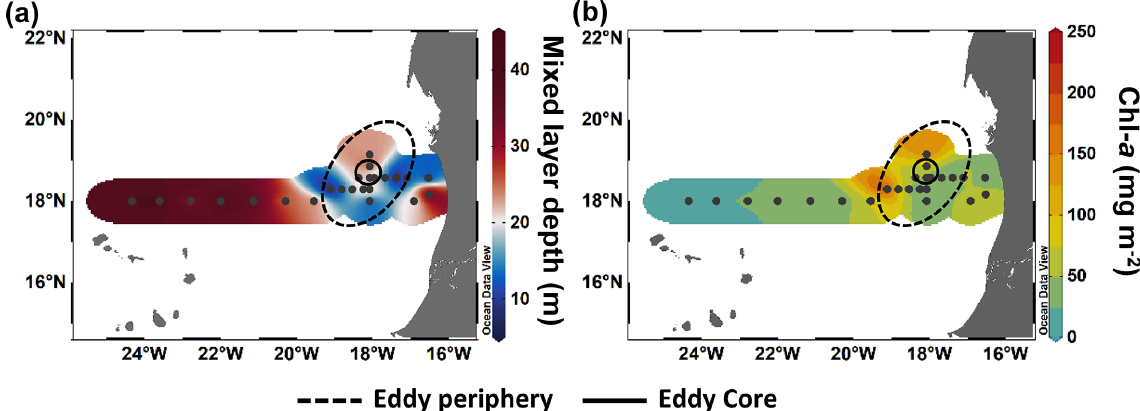
Figure 3. Spatial distribution of maximum mixed layer depth (a) and integrated chlorophyll a (Chl a ) over 100m depth (b) during